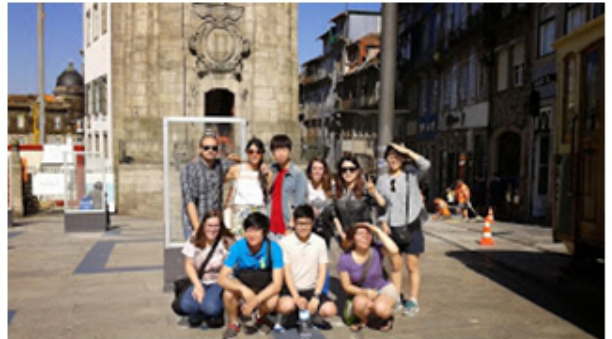
Figure 2. E4SD: Short break in front of the Clérigos Tower